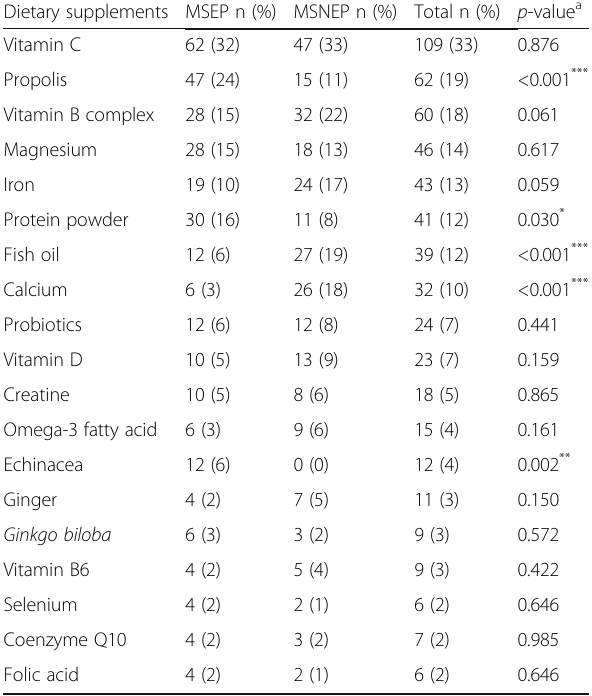
Table 3 The most commonly used DS among medical students Dietary supplements MSEP n (%) MSNEP n (%) Total n (%) p -value a